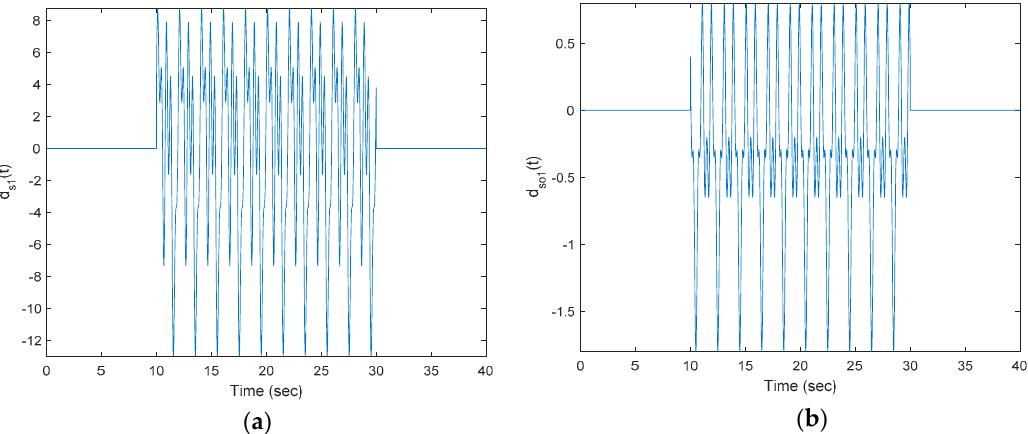
( ) d t (without state-dependent disturbance); ( b ) output disturbance 1 s